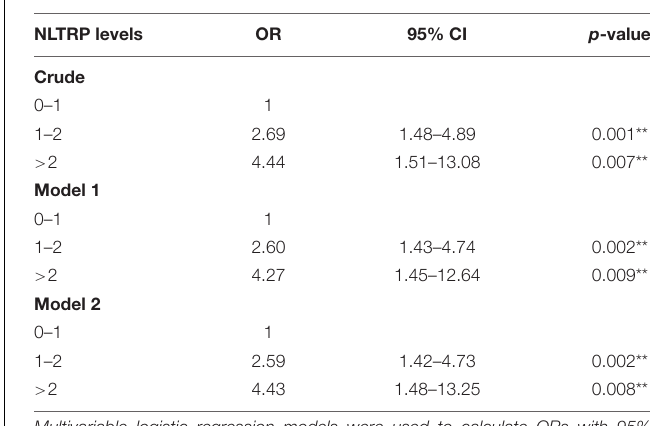
TABLE 2 | The ORs for all-cause deterioration of mTBI across groups of